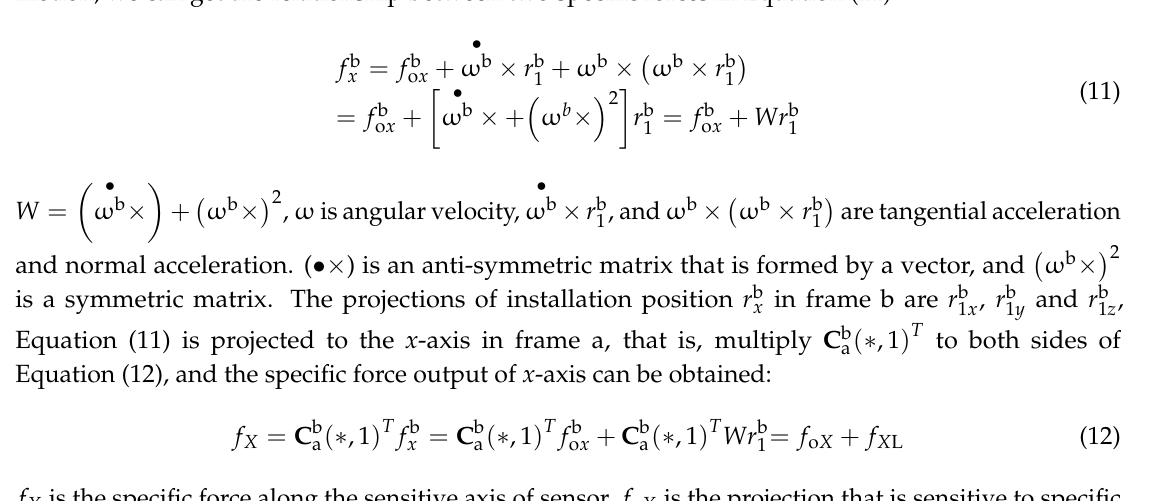
Figure 3. Model of dynamic calibrate for accelerometer A x